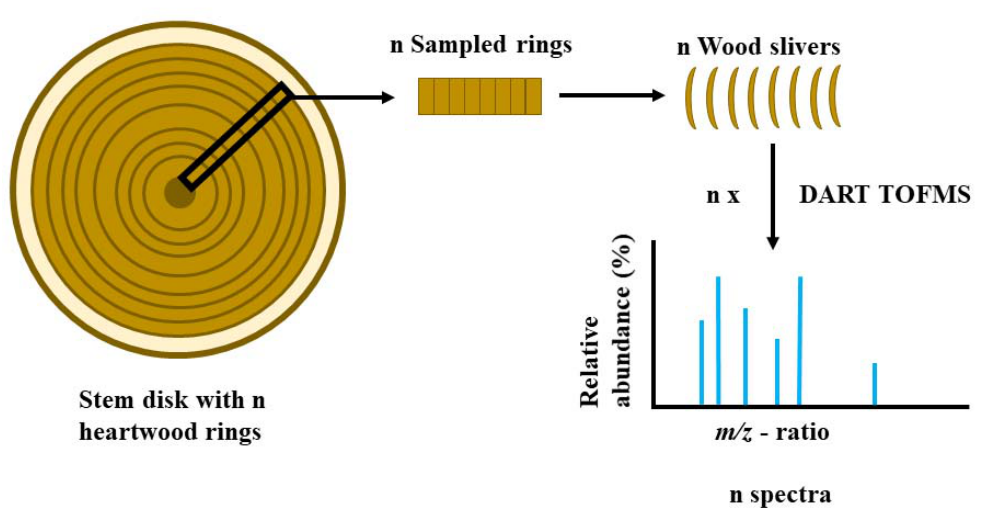
Figure 1. Schematic illustration of the procedure. For every sampled wood sliver, a mass spectrum is obtained.